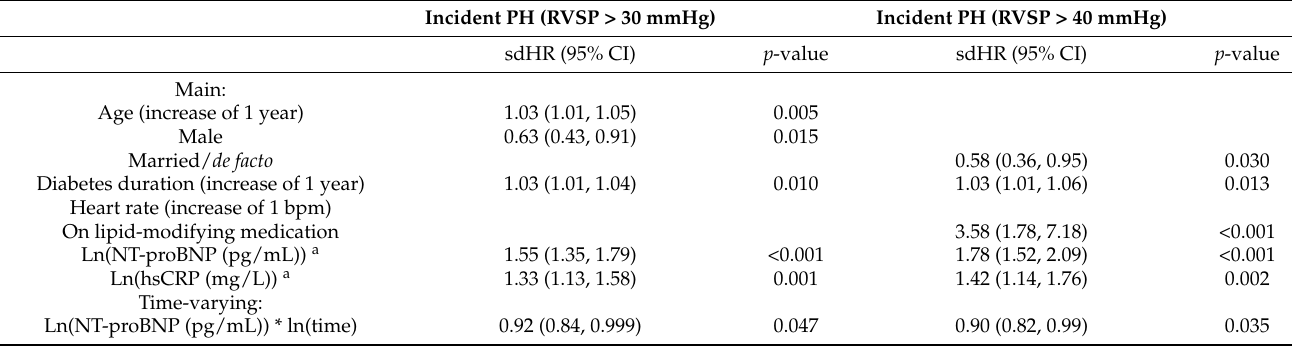
Table 4. Fine and Gray competing risk models of independent determinants of incident pulmonary hypertension (PH). Subdistribution hazard ratios (sdHR) and 95% confidence intervals (CI) are